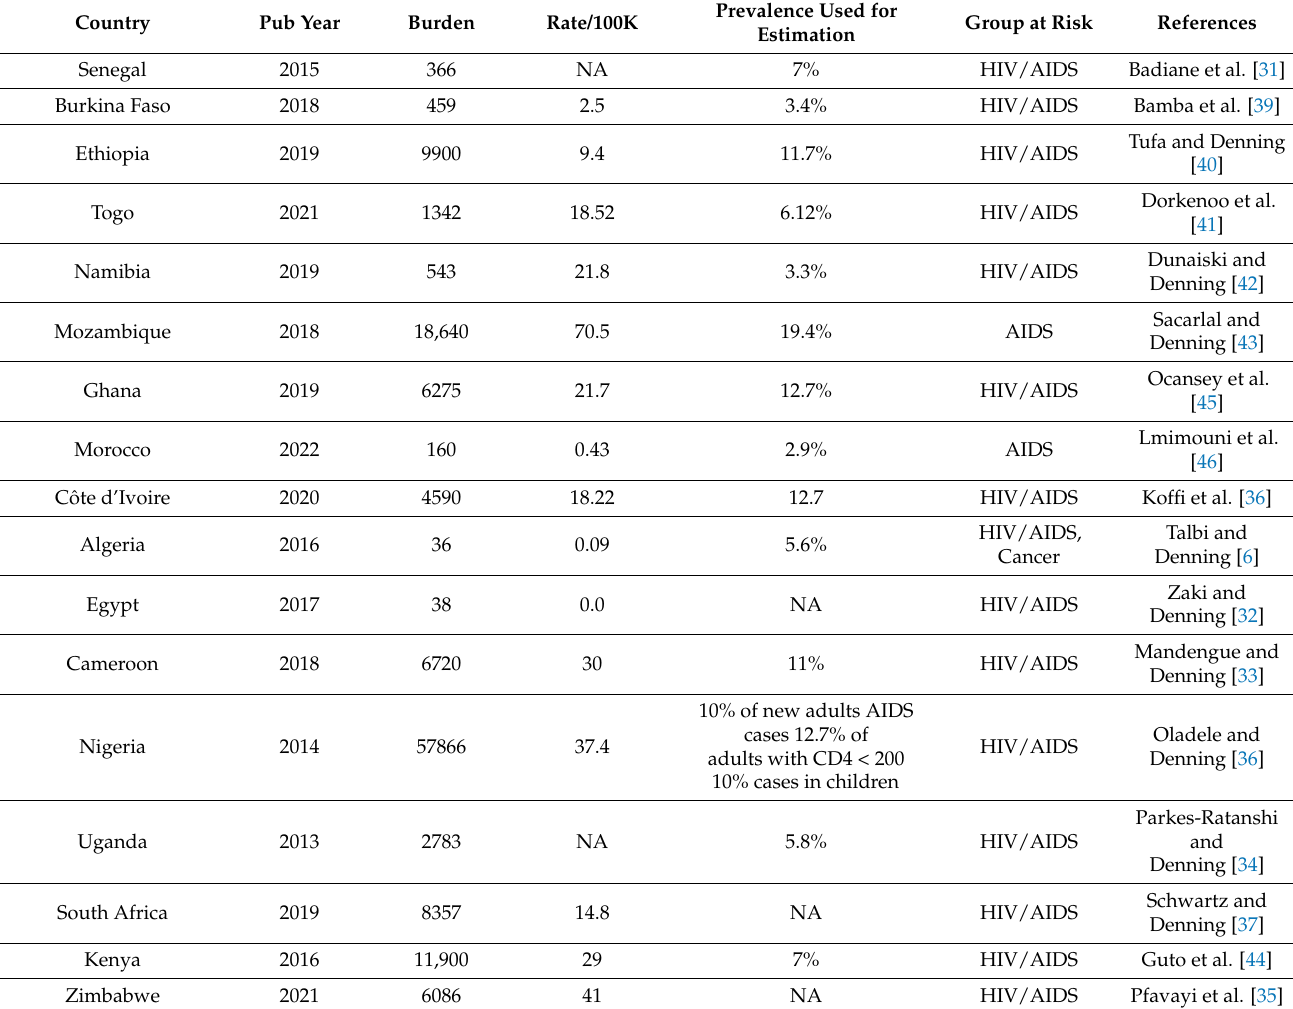
Table 1. Estimated burden of cryptococcosis in some African